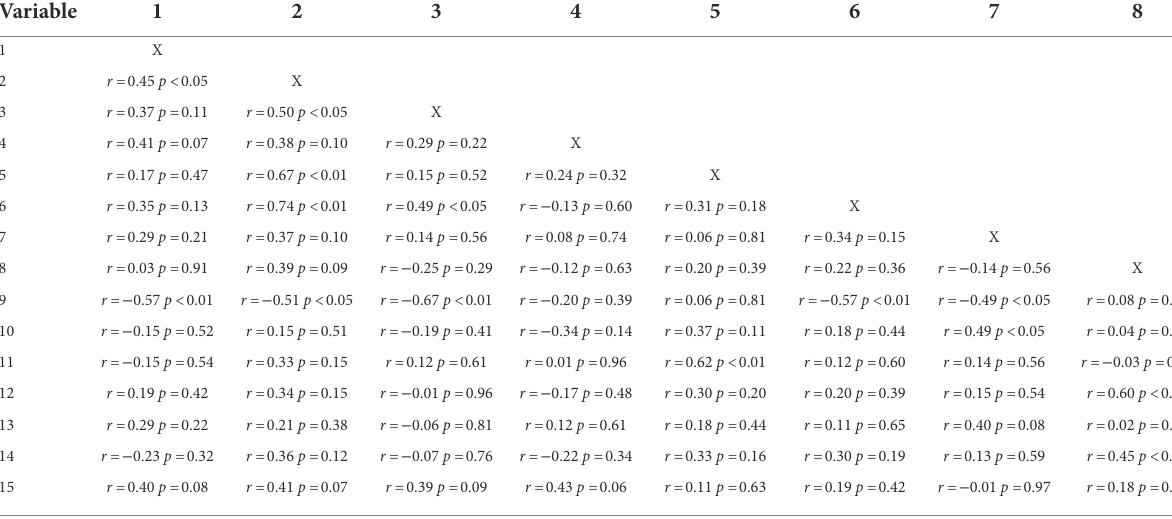
TABLE 7 Correlations between age. Hemodynamic ratios. Number of reels and individual test tasks before the training process. Variable